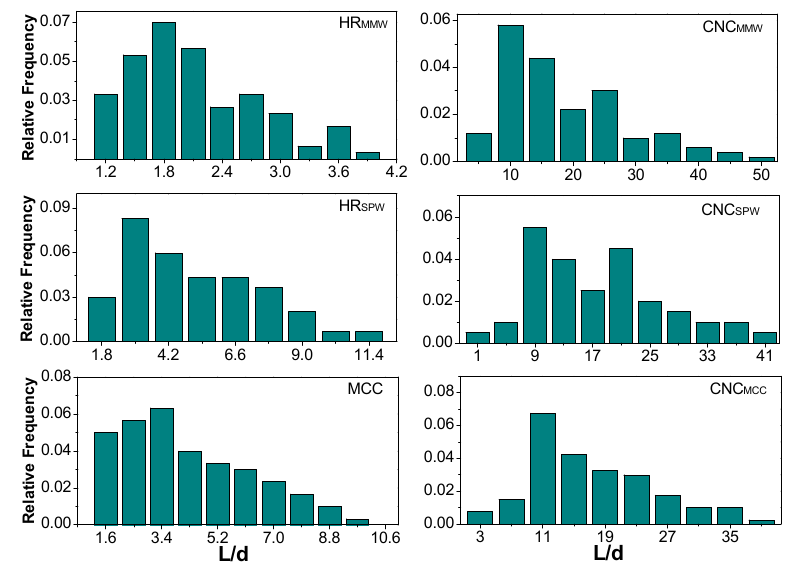
Figure 3. Aspect ratio distributions of HR MMW , HR SPW , MCC, and their CNCs. Table 3. Parameters of bioresiduals and their resulting cellulose nanocrystals.